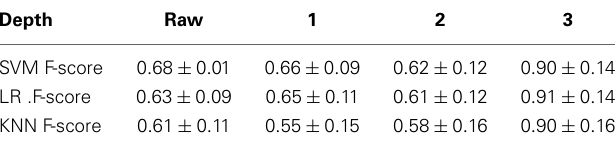
Table 2 | Classification on fine-tuned models (test data).